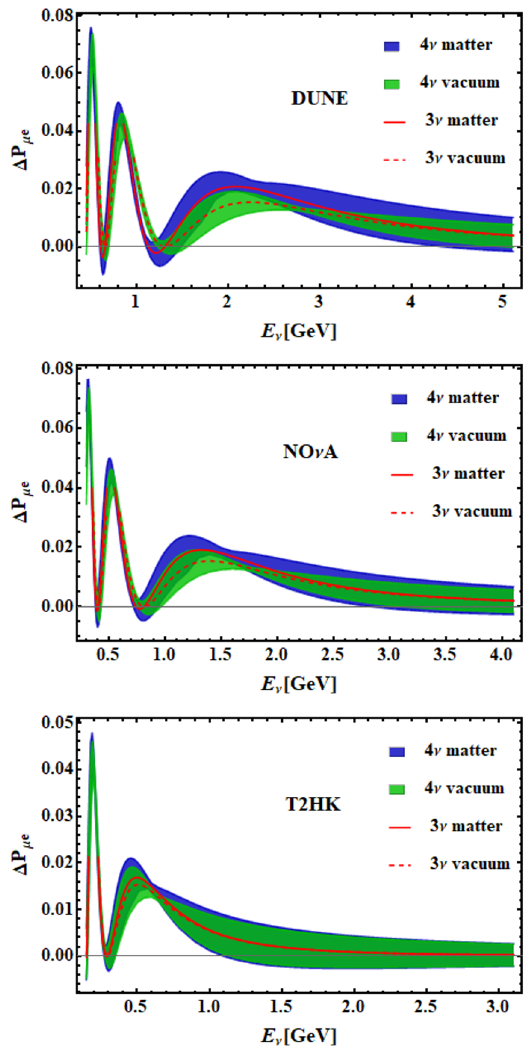
Figure 5 . Shown are the plots of CP asymmetries in the long-baseline experiments DUNE, NO (cid:23) A and T2HK with respect to the neutrino energy, and comparison between the results in 3+0 and 3+1 neutrino